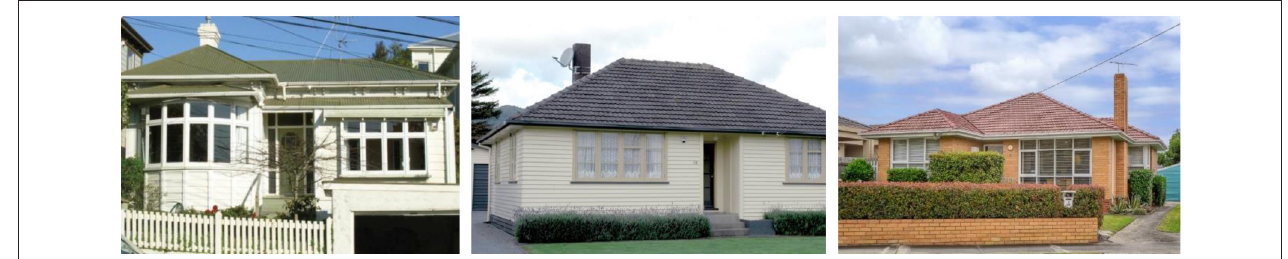
FIGURE 5 | Typical pre-1935 (left) , 1935-1976 (central) and post 1976 (right) residential house in New Zealand (BRANZ, 2019).